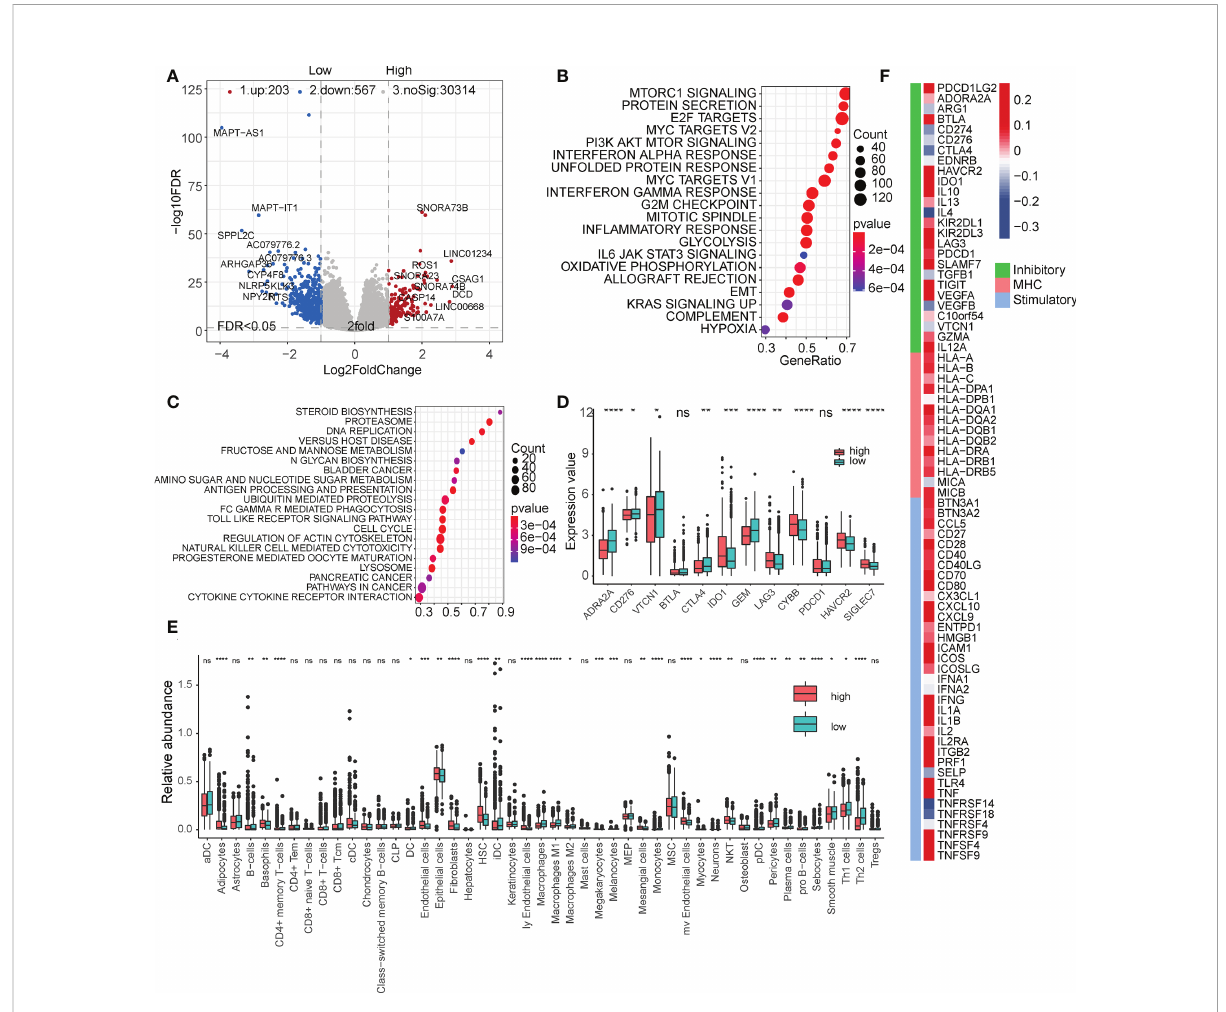
FIGURE 4 Functional analysis of the FibLnc score and breast cancer immune signature. (A) Differentially expressed genes between high- and low-risk subgroups. (B) Hallmark enrichment analysis of the distribution of FibLnc scores. (C) KEGG enrichment analysis of the distribution of FibLnc scores. (D) Analysis of the differences in the distribution of immune checkpoints between high- and low-risk subgroups. ns means P > 0.05, * means P ≤ 0.05, ** means P ≤ 0.01, *** means P ≤ 0.001, **** means P ≤ 0.0001. (E) Analysis of the differences in the distribution of immune cells between high- and low-risk subgroups. ns means P > 0.05, * means P ≤ 0.05, ** means P ≤ 0.01, *** means P ≤ 0.001, **** means P ≤